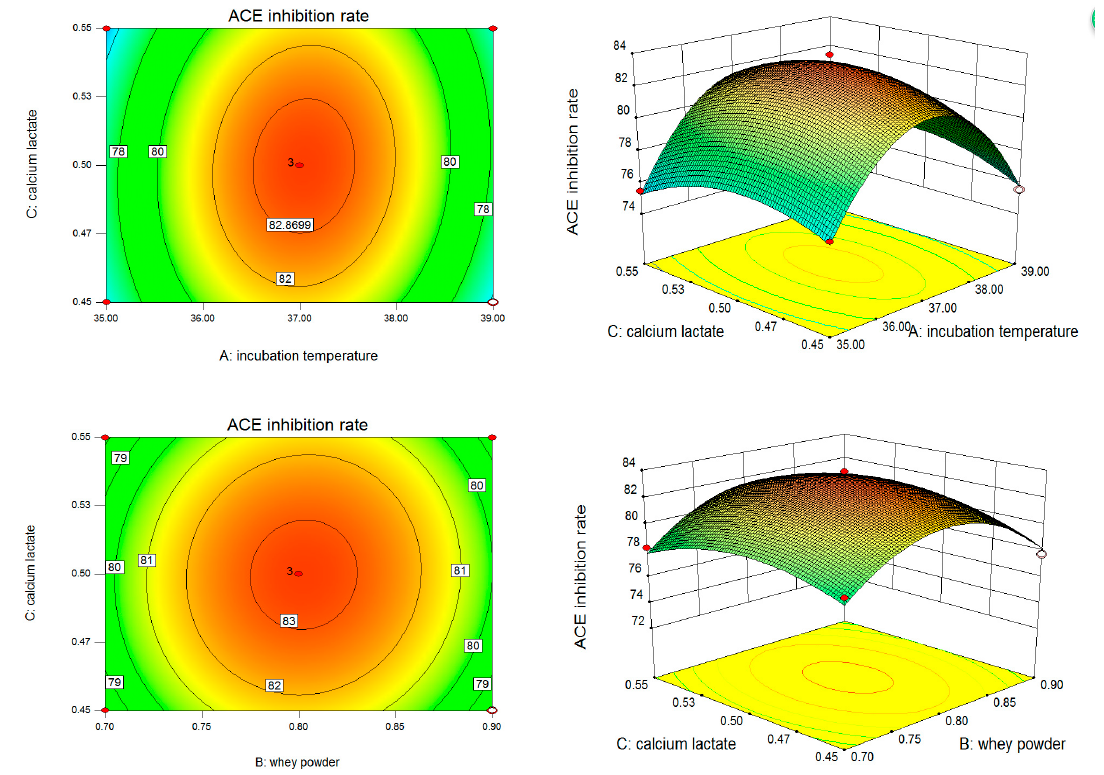
Figure 1. Contour plots and response surface plots of incubation temperature A, whey powder B, calcium lactate C to ACE inhibition rate (R 1 ).